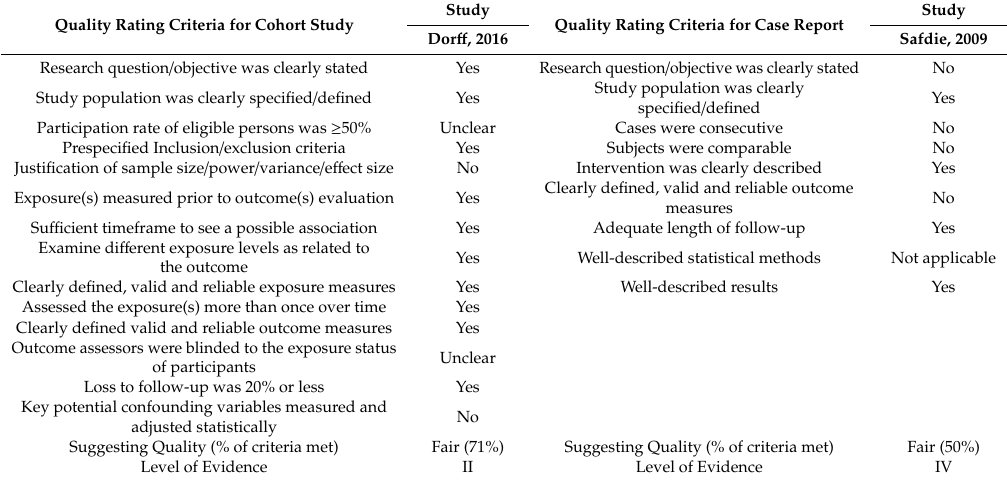
Table 4. Quality and Evidence Level of Cohort Study and Case Report.